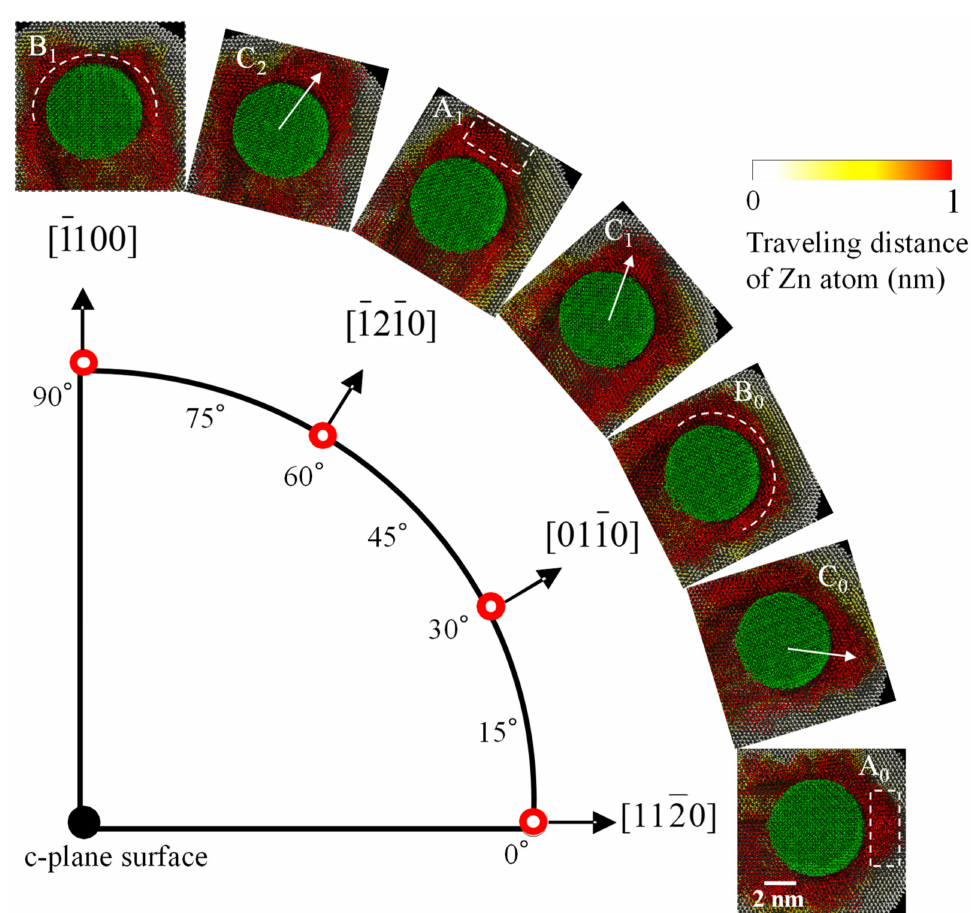
Figure 10. Top views in all the scratch directions to observe the chip formation morphologies, where the color bar shows the traveling distance of Zn atom from initial position (MD).